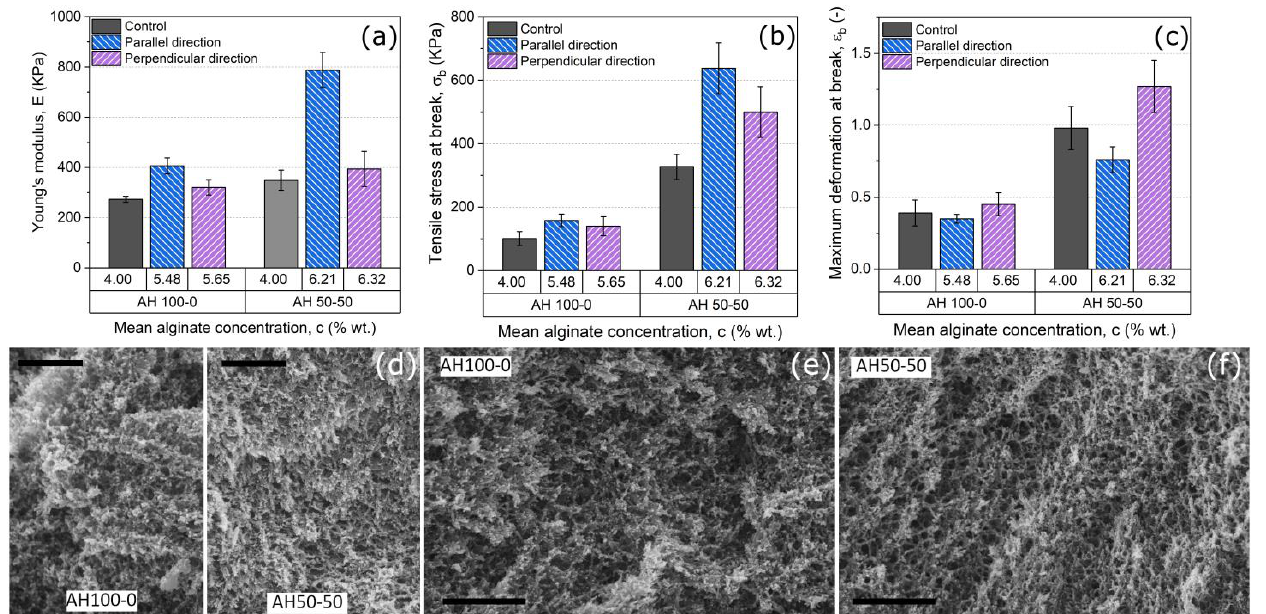
Figure 3. Young's modulus, deformation and stress at break, and microscopic structure of the dehydrated alginate hydrogels under tensile stress. Data for control samples are included for comparison. In each graph ( a – c ) it is shown, from left to right, the value for control samples (C4.0AH100-0 and C4.0AH50-50), the value for samples measured under uniaxial tensile test parallel to the direction of the SCDP stress, and the value for the samples measured under uniaxial tensile test perpendicular to the direction of the SCDP stress. ( d ) SEM images of the polymeric network of AH100-0 and AH50-50 after their preparation (top view). ( e , f ) SEM image of the polymeric network of AH100-0 and AH50-50 (top view), respectively, after a tensile controlled dehydration process of 24 hours duration. Scale bars correspond to 1 µm.